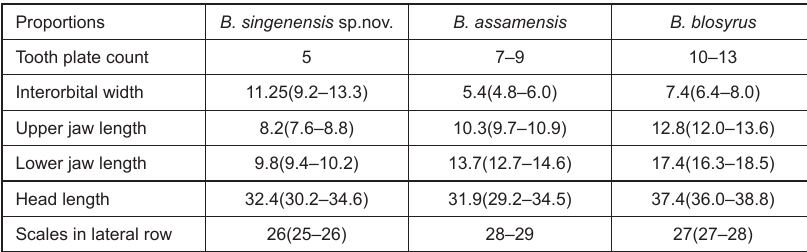
Live colours: body dark slaty gray dorsally, paler on sides, each scale with reddish tinge; dorsal fin reddish, tips of fin rays black. Caudal fin orange, paired fins and anal fin slaty gray with reddish tinge. Posterodorsally on opercle, at base of opercular spine, a rounded black spot covering 3-4 scales. Three distinct dark black blotches surrounded by red coloration at dorsal fin base: the first behind the third dorsal spine, the second behind the sixth dorsal spine and the third, behind the fifth dorsal soft ray. A black blotch at the base behind the fifth soft anal fin ray.